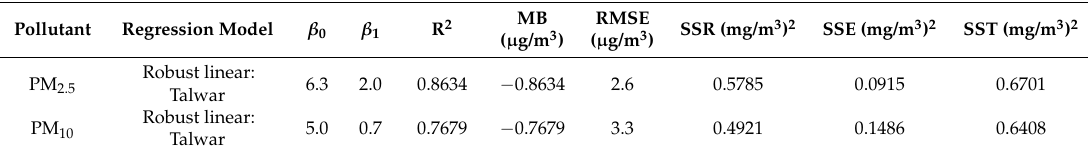
Table 4. Statistical summary of the best regression models achieved from PM 2.5 and PM 10 sensors laboratory calibration (N = 13,222).